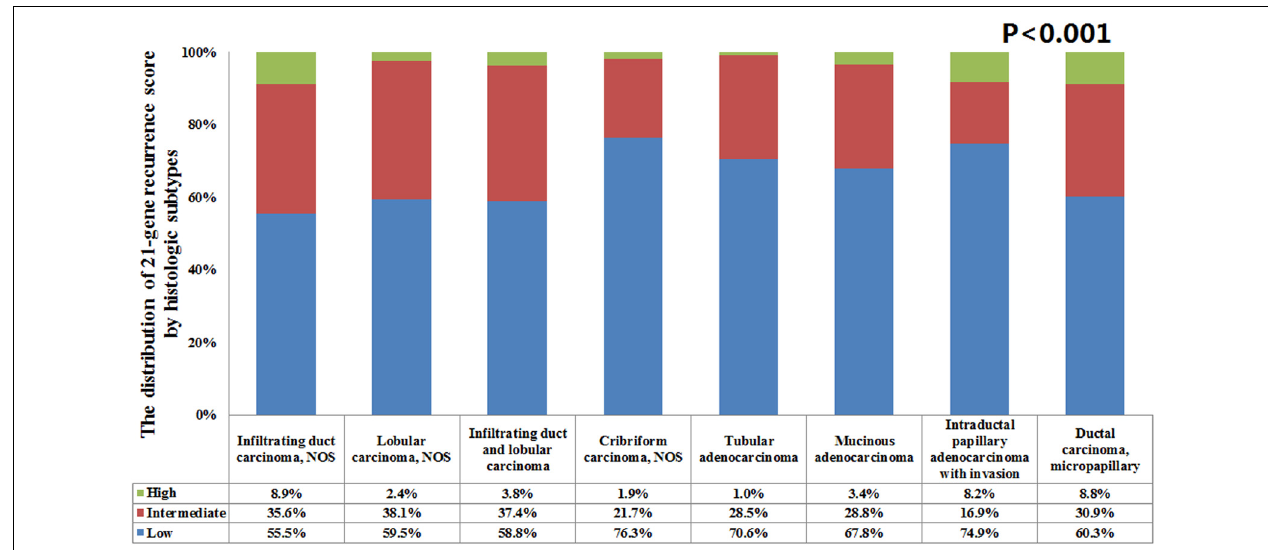
FIGURE 1 | The distribution of 21-gene recurrence score among histologic subtypes of breast cancer.